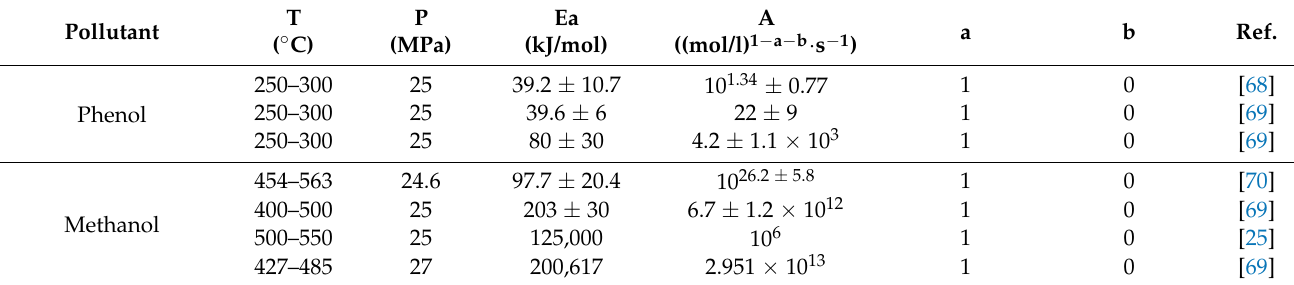
Table 4. Kinetic parameters values for SCWO reaction of some organic